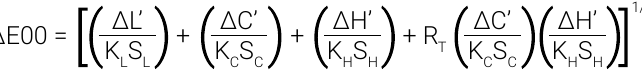
Table 1. Mean (standard deviation) of the contact angles according to the solution and time tested in this study. Solution Distilled water (DW)